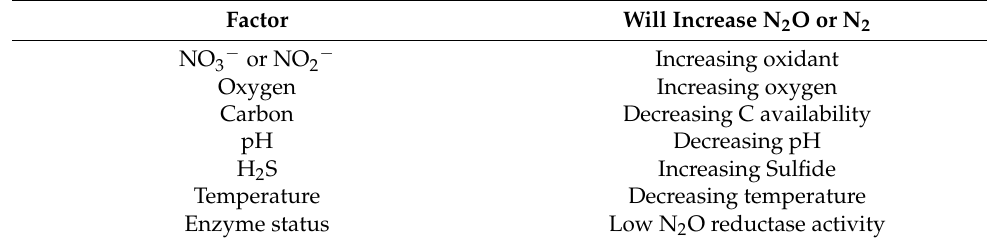
Table 3. Factors affecting the proportion of N 2 O and N 2 produced during denitrification